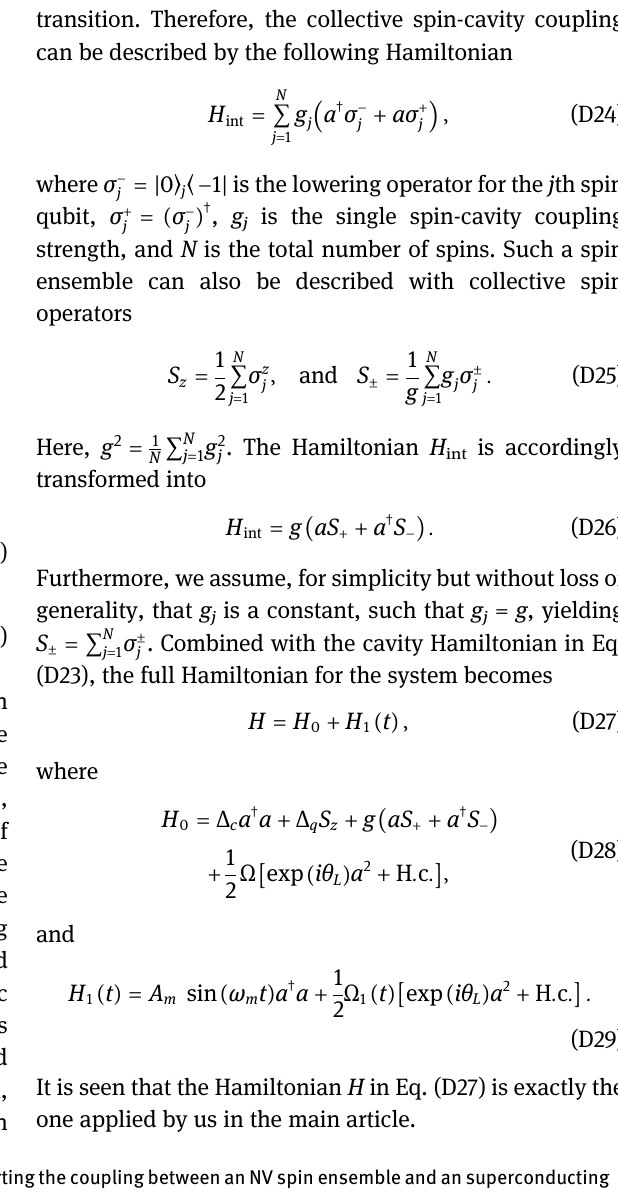
transmissionline(STL)cavity.Here, ω c isthecavityfrequency, Q isthequalityfactorofthecavity, κ isthelossrateofthecavity, N isthenumber ofNVcentersintheensemble, g col isthecollectivecouplingoftheensembletothecavity, γ ϕ isthedephasingrateoftheensemble,and γ isthe energy relaxation rate of the ensemble. Note that the superscript “ ⋆ ” indicates that the cavity frequency is tunable via a superconducting quantum interference device